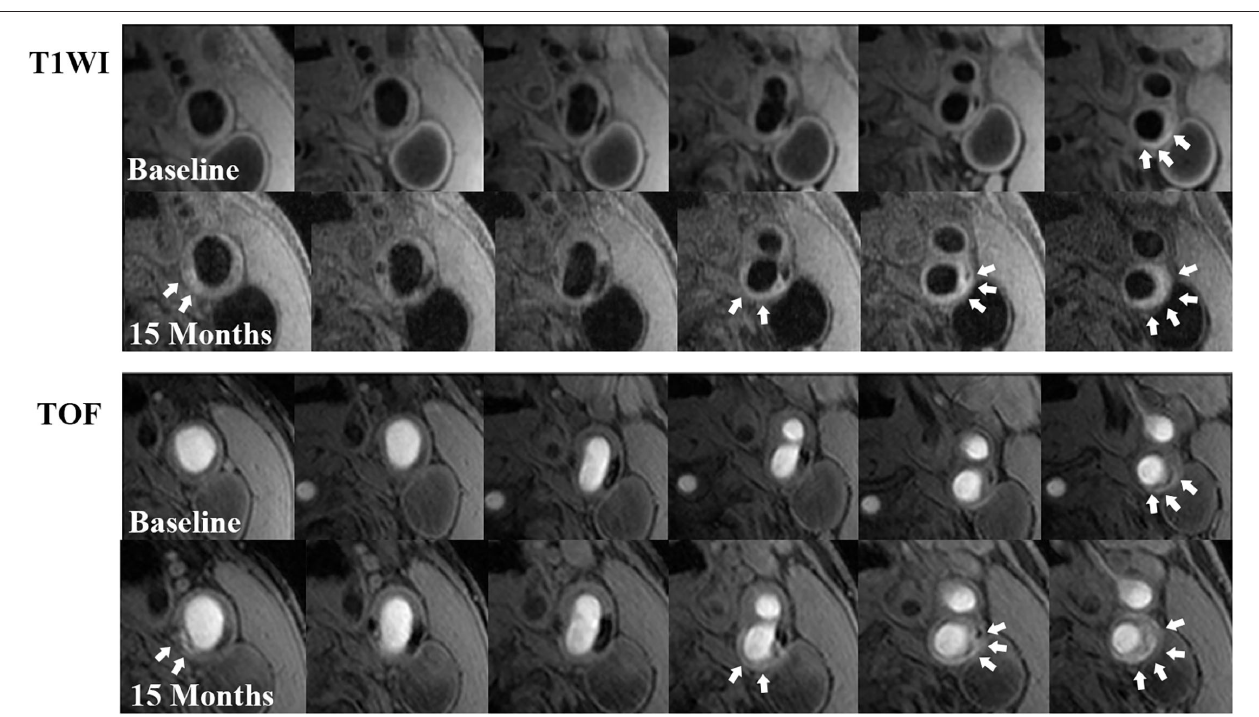
FIGURE 2 | Examples of IPH progression during a 15-month follow-up. There is a remarkable progression in IPH volume (white arrows) at left carotid bifurcation with atherosclerosis on T1W (above 2 rows) and TOF (below 2 rows) images from the baseline to the follow-up. In addition, new IPHs (white arrows) could be observed at other locations of the plaque on follow-up MR images compared with those at